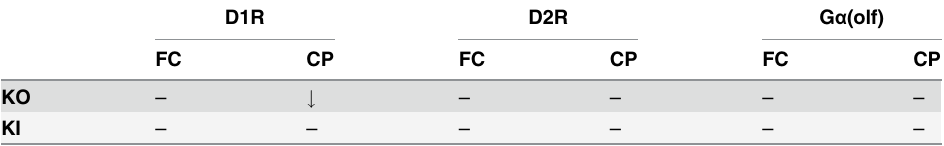
A summary of the changes in D1R, D2R and G α (olf) expression at postnatal day 14 (P14) in the frontal cortex (FC) and caudate-putamen (CP) in the Dyt1 KO (KO) and Dyt1 KI (KI) lines of mouse. # indicates statistically signi fi cant reductions in expression compared to wild-type control mice. — indicates no statistically signi fi cant